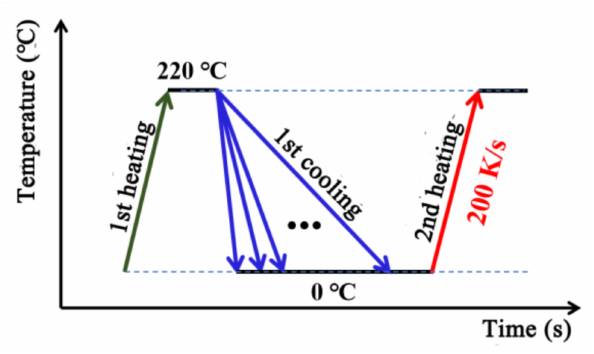
Figure 1. Temperature–time profile of Flash DSC experiments. Table 1. Detailed cooling rates in the FSC measurement process.